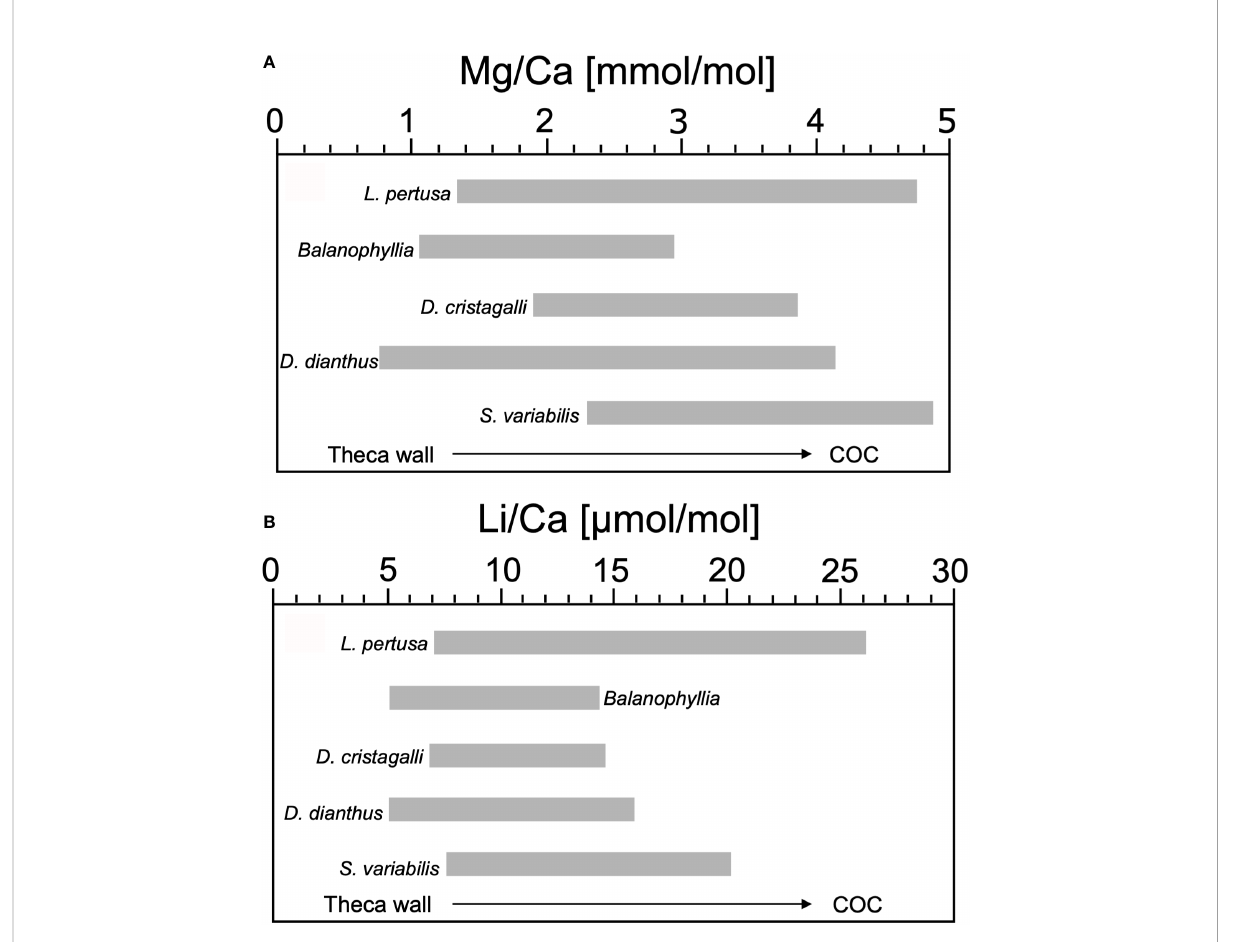
FIGURE 7 Comparison of the Mg/Ca [mmol/mol] and Li/Ca [µmol/mol] in the internal skeleton structure of different CWC ’ s: L. pertusa, Balanophyllia, D. cristagalli, D. dianthus and S. variabilis. (A) In L. pertusa, Mg/Ca vary in a range of 1.5-4.6 mmol/mol (Raddatz et al., 2013; Rollion-Bard and Blamart, 2015; Schleinkofer et al., 2019), in Balanophyllia 1.2-2.8 mmol/mol (Case et al., 2010), in D. cristagalli 2.0-3.7 mmol/mol (Rollion-Bard and Blamart, 2015), in D. dianthus the range of values extends of 0.9-4.0 mmol/mol (Gagnon et al., 2007; Case et al., 2010), and in S. variabilis between 2.4-4.7mmol/mol (this study). (B) Li/Ca range from 8.0-25.3 m mol/mol in L. pertusa (Raddatz et al., 2013; Rollion-Bard and Blamart, 2015), 6.0-13.5 m mol/mol in Balanophyllia (Case et al., 2010), in D. cristagalli 7.7-13.8 m mol/mol (Rollion-Bard and Blamart, 2015), in D. dianthus 6.0-15.0 m mol/mol (Case et al., 2010), and in S. variabilis 8.5-19.3 m mol/mol (this